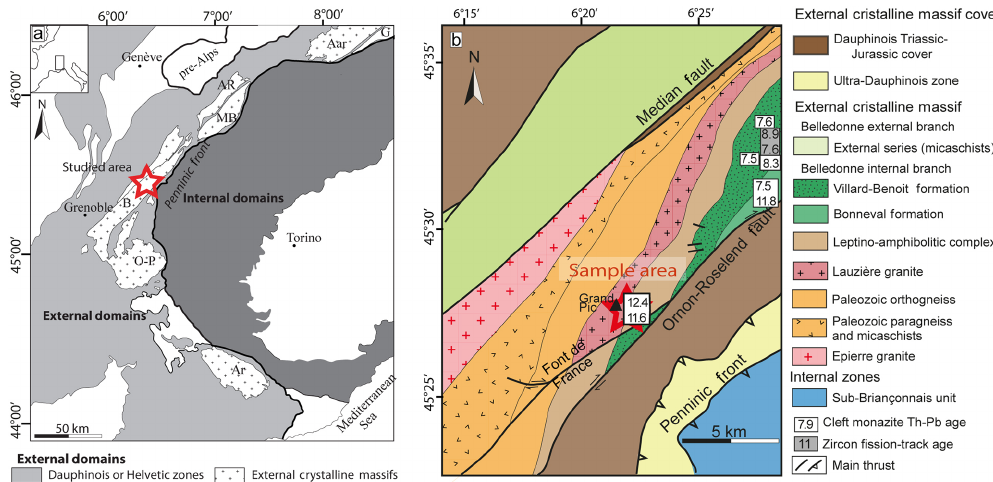
Figure 1. Simplified geological maps showing the location of the investigated area (red star). (a) Western Alps with the location of the external crystalline massifs: Aar; G: Gotthard; AR: Aiguilles Rouges; MB: Mont Blanc; B: Belledonne; P: Pelvoux; O: Oisans; Ar: Argentera. (b) Main geological units of the Lauzière massif. Grey rectangles are zircon fission-track central ages (Fügenschuh and Schmid, 2003), white rectangles are cleft monazite Th-Pb ages (Gasquet et al., 2010; Grand’Homme et al., 2016).